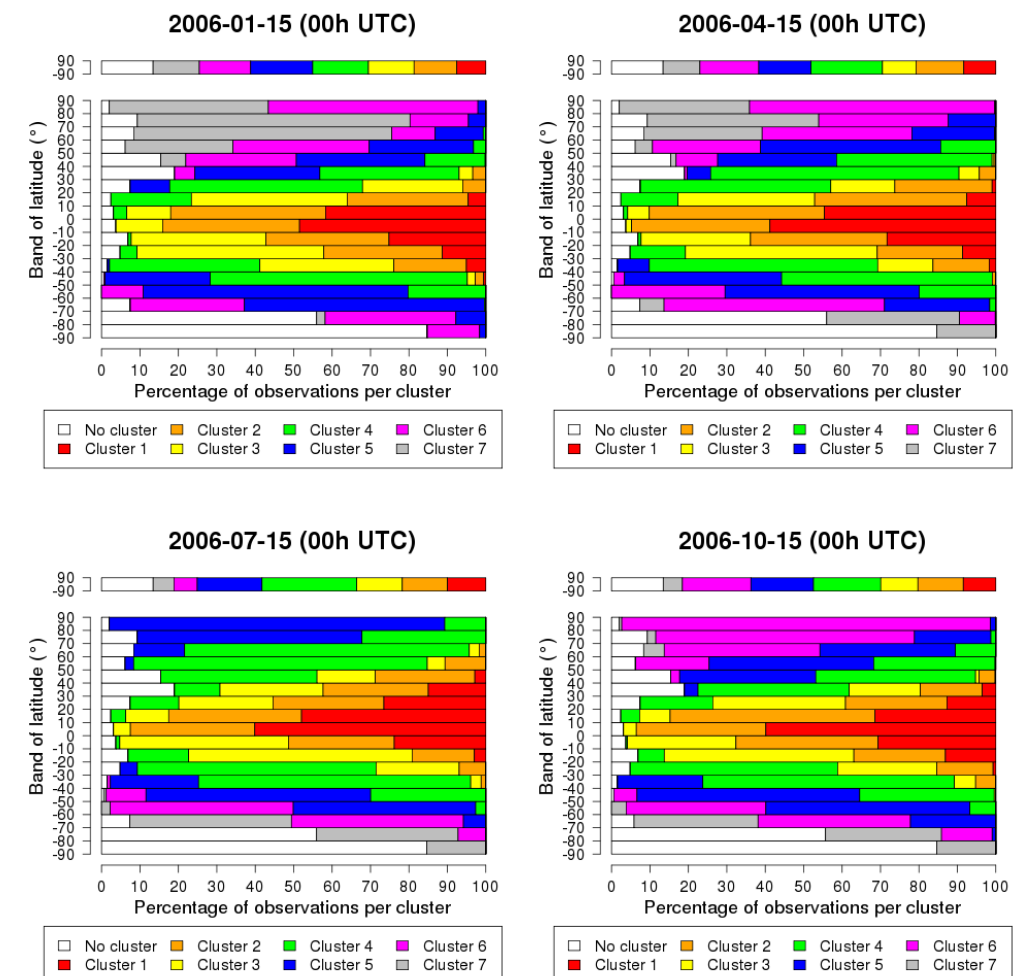
Figure 7. Percentage of observations per cluster on the whole band of latitude and per 10 ◦ band of latitude, obtained with EM-VII, for 4 months. The “No cluster” label corresponds to the high relief atmospheric